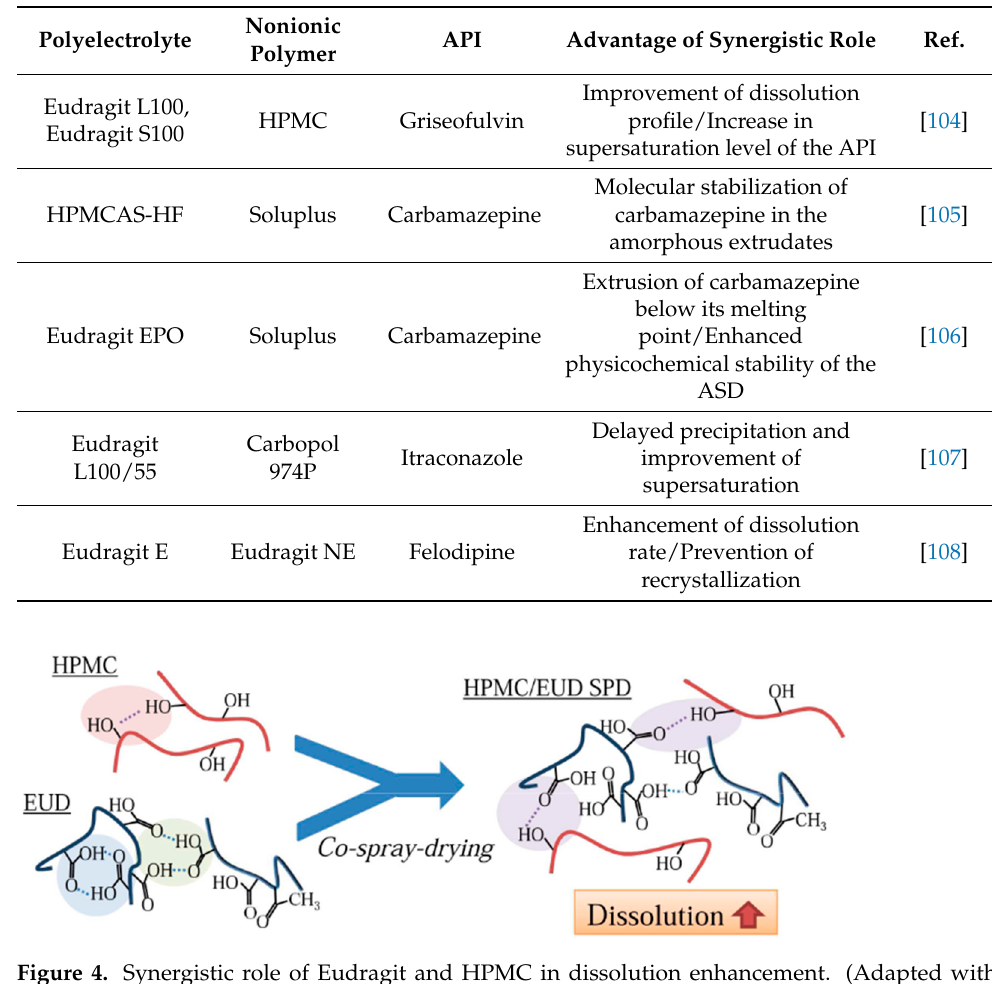
Table 2. Advantages of the synergistic role of combination polyelectrolytes with nonionic polymers.